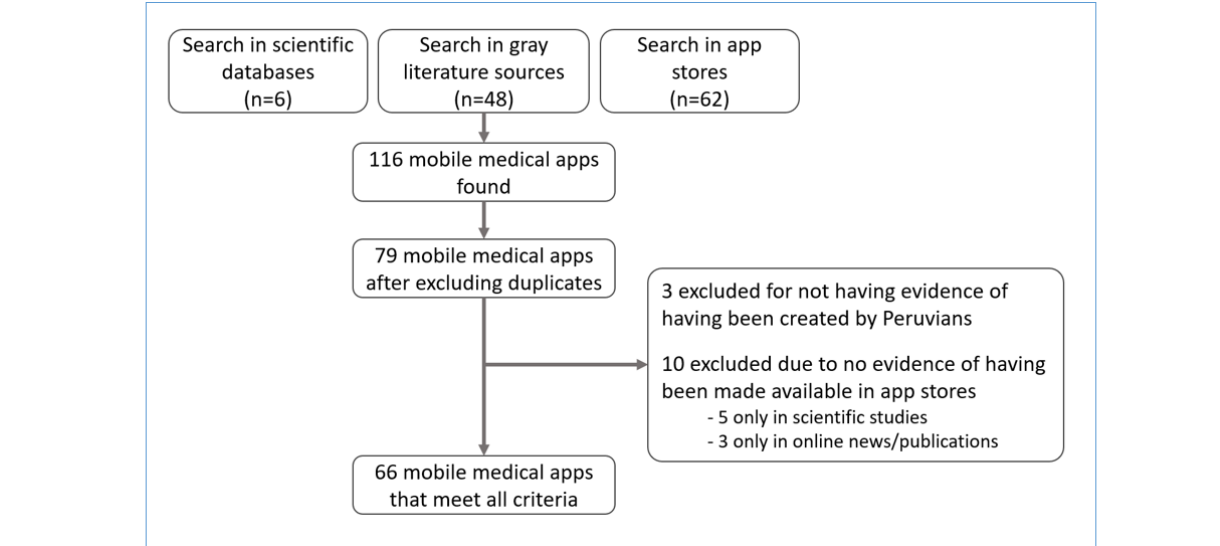
Figure 1. Flowchart of Peruvian mobile medical app